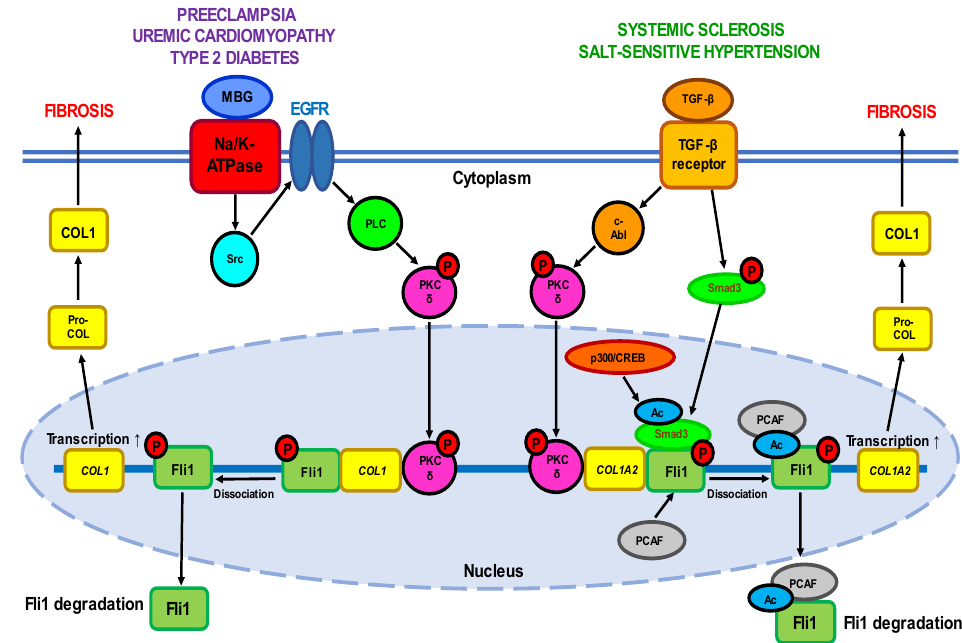
Figure 1. A simplified scheme of the Fli1-dependent pro-fibrotic pathways described for different diseases. One of the pathways is induced by interaction of active TGF- β with its plasma membrane receptor and depends on the ratio between the COL1 -suppressive activity of Fli1 and the stimulatory ability of Smad3. TGF- β -dependent activation leads to phosphorylation of c-Abl which in turn in- duces nuclear translocation of PKC- δ. In the nucleus, PKC- δ phosphorylates Fli1 at threonine 312 thus facilitating the acetylation of Fli1 at lysine 380 by PCAF (p300/CREB-binding protein-associated factor). These events result in dissociation of Fli1 from promoter of the COL1A2 gene and its rapid proteolysis, followed by increased transcription of the COL1 gene. On the other hand, activation of TGF- β receptor phosphorylates Smad3 which moves into the nucleus and undergoes acetylation by the p300/CREB-binding protein which increases its DNA binding capacity with the promoter of the COL1A2 gene. The second pathway is triggered by binding of MBG to the plasma membrane Na-K- ATPase, which results in phosphorylation of tyrosine kinase Src followed by sequential phosphor- ylation/stimulation of PLC and PKC- δ. Active PKC- δ is translocated to the nucleus where it disrupts Fli1 repression of the COL1 gene leading to the loss of Fli1 activity and excessive collagen synthesis. 2. Diseases Associated with Fli1 Deficiency 2.1. Fli1 in Systemic Sclerosis Fli1 as inductor of fibrosis. Systemic sclerosis (SSc or scleroderma) is a complex and highly heterogeneous autoimmune disease starting from dysregulation of the immune system and inflammation and followed by impaired angiogenesis, widespread vascular injury, and blood coagulation defects [22]. Persistently activated interstitial fibroblasts in- duce irreversible fibrosis of the skin and multiple internal organs. Except skin lesions, SSc is accompanied by cardiac defects (lesions in the coronary arteries, pericardium, and my- ocardium, and myocardial fibrosis) and renal failure (vascular lesions and fibrosis in the kidney, damage to renal glomeruli, and impaired glomerular filtration).